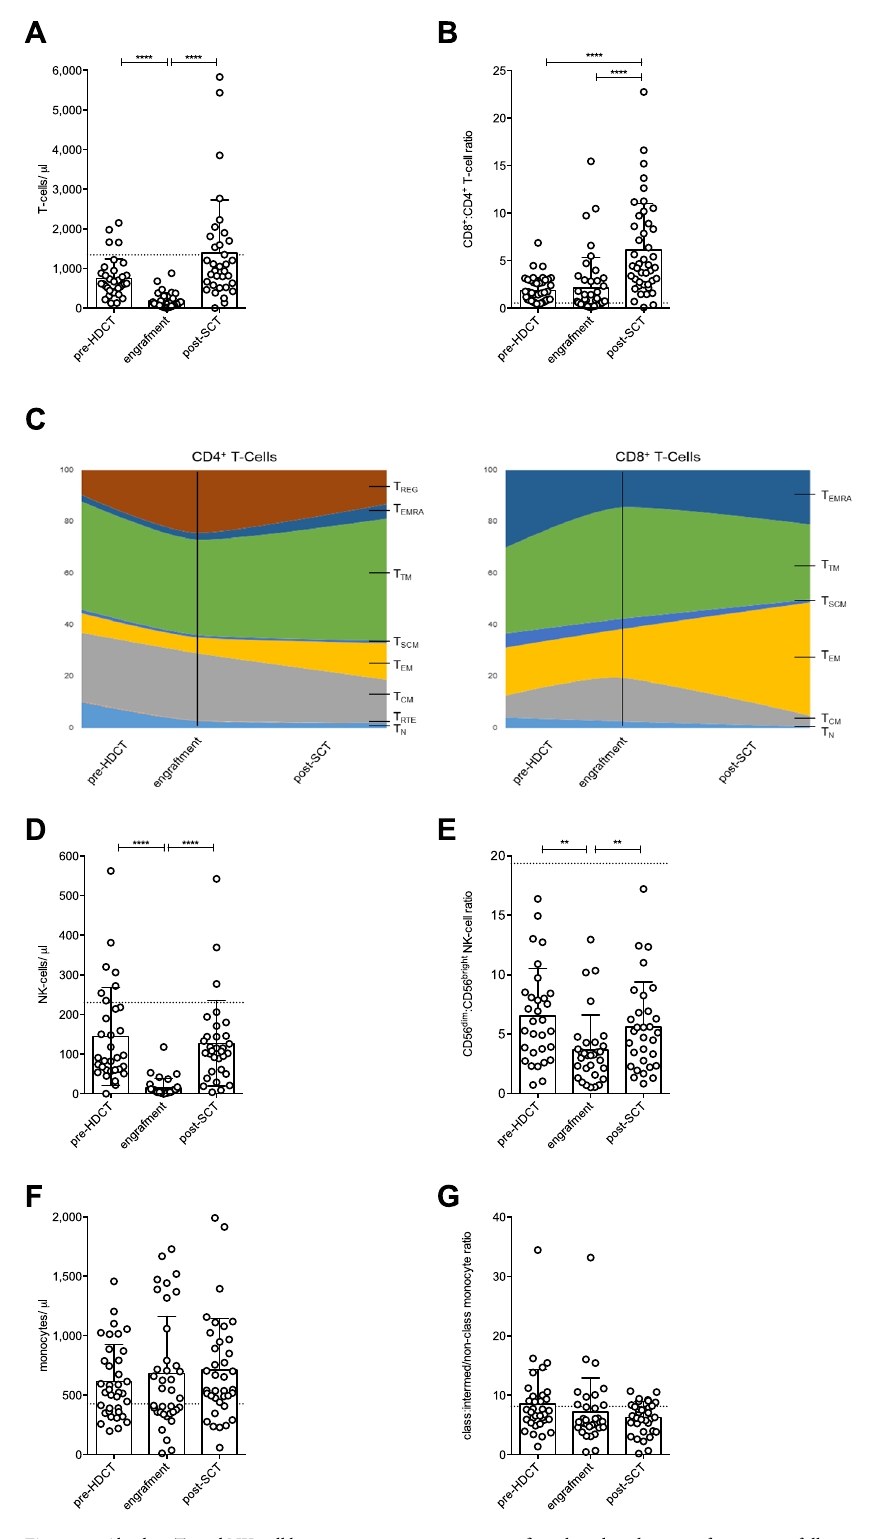
Figure 1. Absolute T- and NK-cell but not monocyte count is significantly reduced at engraftment time following HDCT/ auto-SCT. ( A ) Analysis of absolute CD3 + T-cell count in MM and lymphoma patients (n: 34; mean +/− standard deviation SD) during HDCT/ auto-SCT. ( B ) Course of CD8 + :CD4 + T-cell ratio (n: 43; mean+/− SD). ( C ) Distribution of various differentiation stages of CD4 + and CD8 + T-cells (n: 10) including naïve (N), recent thymic emigrants (RTE), stem cell memory (SCM), central memory (CM), transitional memory (TM), effector memory (EM), effector memory CD45RA + (EMRA) and regulatory T-cells (REG) . ( D ) Analysis of absolute NK-cell count (n: 32; mean +/− SD) during HDCT/ auto-SCT. ( E ) Course of CD56 dim :CD56 bright NK-cell ratio (n: 31; mean +/− SD). ( F ) Analysis of absolute monocyte count (n: 37; mean +/− SD) during HDCT/ auto-SCT. ( G ) Course of classical:intermediate/non- classical monocyte ratio (n: 34; mean +/− SD). The mean of a healthy donor control group (n: 52 from A.H. Kverneland et al. 61 ) is shown as a horizontal dashed line for reference. Statistical significance was determined using a Friedman test with Dunn’s multiple comparison tests for repeated measurements. **P < .01; ****P <